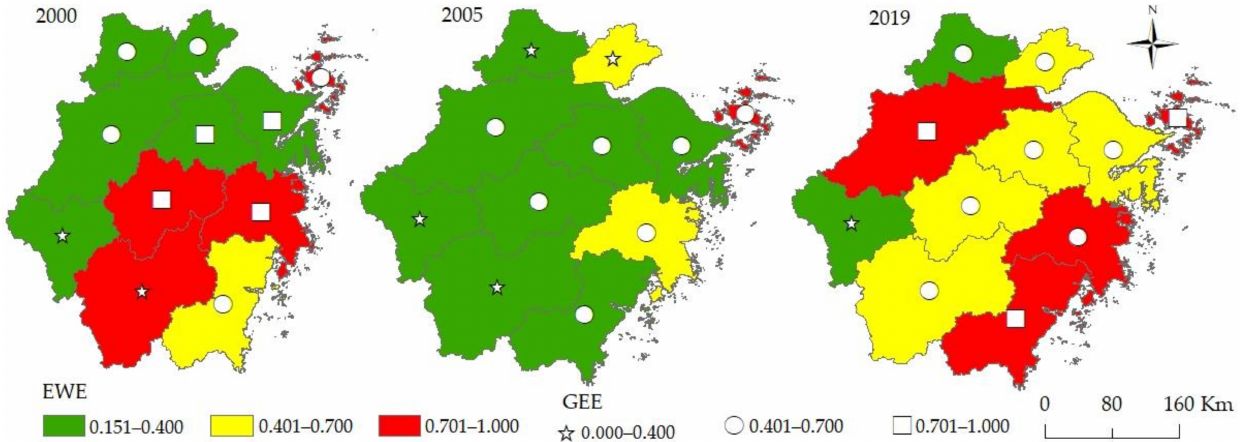
Figure 3. The spatial and temporal evolution of green economic efficiency and ecological welfare performance of cities in the Zhejiang